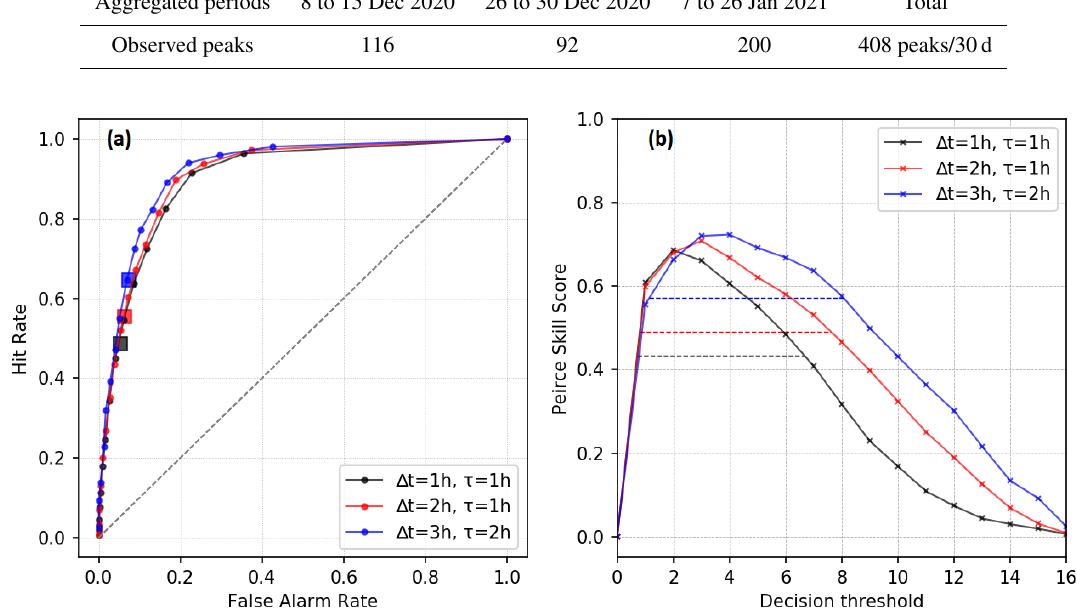
Figure 14. ROC curves (a) and the PSS as a function of decision thresholds (b) of the pX ensemble simulations performed with Pasquill stability classes by aggregating simulations and observations at all stations. There is one curve for each ( (cid:49)t,τ ): ( (cid:49)t = 1 h,τ = 1 h ), ( (cid:49)t = 2 h,τ = 1 h ), ( (cid:49)t = 3 h,τ = 2 h ). The values of the scores for the deterministic pX simulation are indicated by squares in the ROC curves and by horizontal dashed lines in the PSS curves. The diagonal dashed lines are the no-skill lines ( H = F ).